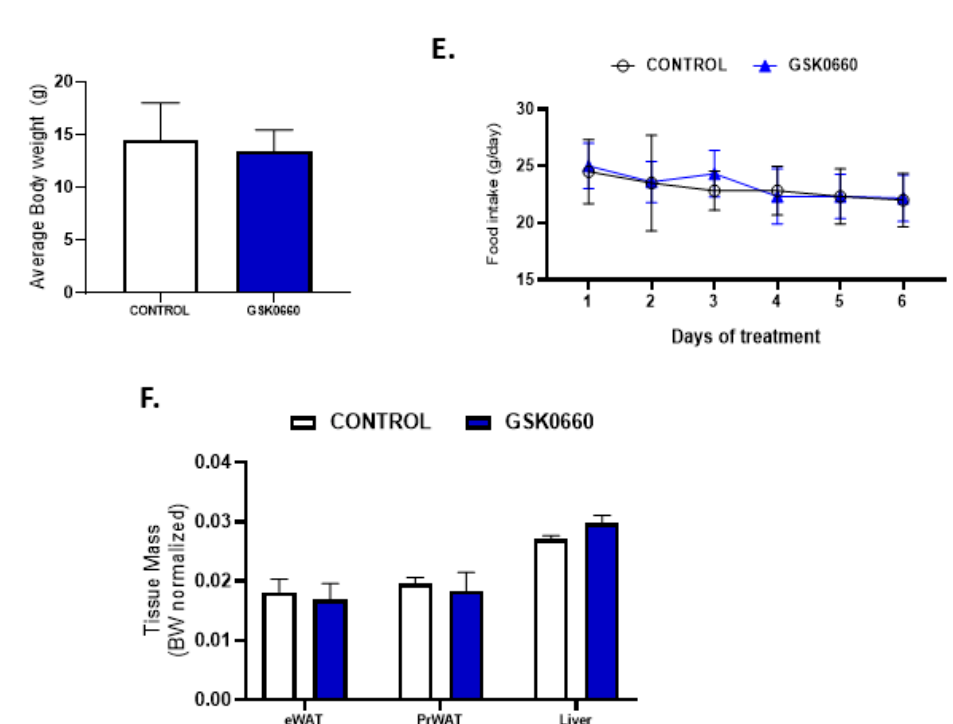
Figure 1. Change in body weight ( A ) and food intake evolution ( B ) of rats after 7 days of chronic central treatment of vehicle (SS and PF), leptin, or leptin and ip GSK0660 co-administration ( n = 6–8). ( C ) Tissue mass of epididymal white adipose tissue (eWAT), peritoneal white adipose tissue (PrWAT) and liver in rats after 7 days of chronic central treatment of vehicle (SS and PF), leptin, or leptin and ip GSK0660 co-administration ( n = 6–8) Change in body weight ( D ) and food intake evolution ( E ) of rats after 7 days of vehicle (DMSO) control or antagonist GSK0660 intraperitoneal injection ( n = 6). ( F ) Tissue mass of epididymal white adipose tissue (eWAT), peritoneal white adipose tissue (PrWAT) and liver in rats after 7 days of vehicle (DMSO) control or antagonist GSK0660 intraperitoneal injection ( n = 6). Results are the mean ± SEM per group of animals ( n = 6–8). Differences between CONTROL vs. GSK0660 treatment were analyzed by Student’s t -test (* p < 0.05; ns: non-significant). Significant differences between ICV-treated rats were analyzed Student’s t -test, SS vs. Lep * p ≤ 0.05; Lep vs. Lep+GSK0660 # p < 0.05). Significant differences between ICV-treated rats were analyzed by One-Way ANOVA followed by Tukey test (differences letters mean significant differences among treatments, p ≤ 0.05). a p ≤ 0.05 vs. PF or Lep or Lep+GSK0660; b p ≤ 0.05 vs. SS or PF or Lep+GSK0660; c p ≤ 0.05 vs. SS or PF or Lep. SS: vehicle-infused rats fed ad libitum; PF: vehicle-infused pair-fed rats; Lep: leptin-infused rats; Lep+GSK0660: leptin-infused rats plus PPAR β / δ antagonist GSK0660.